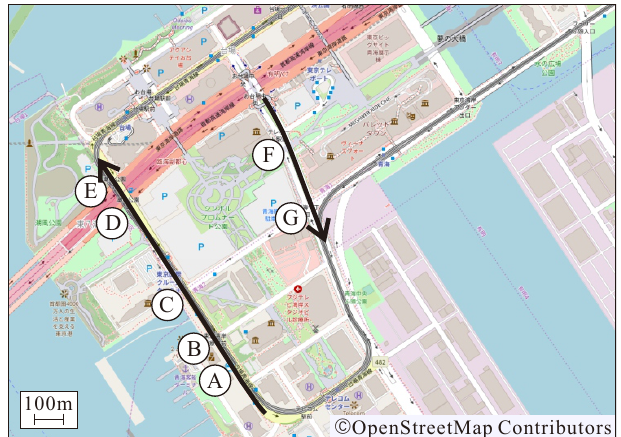
Figure 21. Driving routes for verification